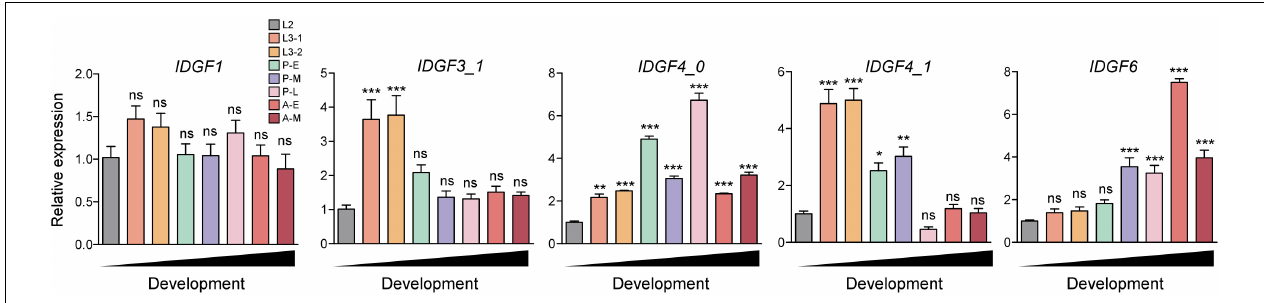
FIGURE 3 | Temporal expression of eight developmental stages of Z. cucurbitae was determined, RNA was extracted from the whole body of flies in different developmental stages including 2nd instar larvae (L2), 3rd early-instar larvae (L3-1), Third late instar larvae (L3-3), 1–2 days mixed pupae as early pupae (P-E), 5–6 days as mid pupae (P-M), and 7–9 days as of late pupae (P-L), 1–2 days adults as (A-E), and 10-day adults as (A-M). We had presented our results after normalization against reference gene EF α 1 as the relative expression. All IDGFs gene expression is relative to the gene expression of each gene in 2nd instar larvae. One-way ANOVA with post hoc Tukey test was used to test the statistical significance * p < 0.05; ** p < 0.01; *** p ≤ 0.001, ns: not